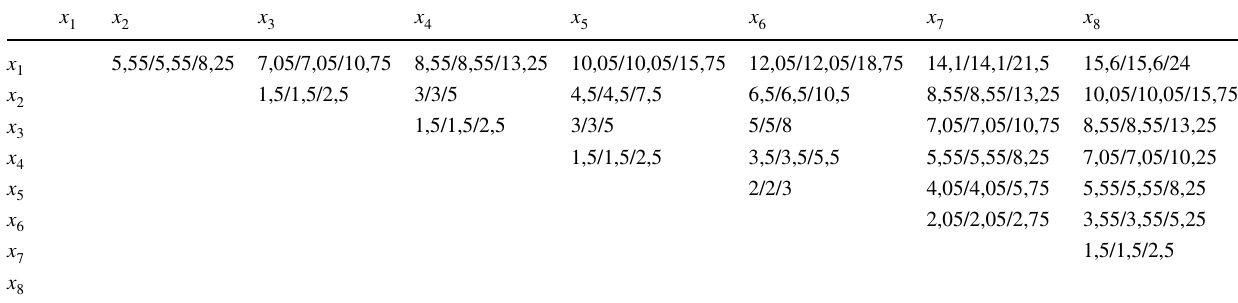
Table 6 Final matrix of Fuzzy-MACBETH method for the second example